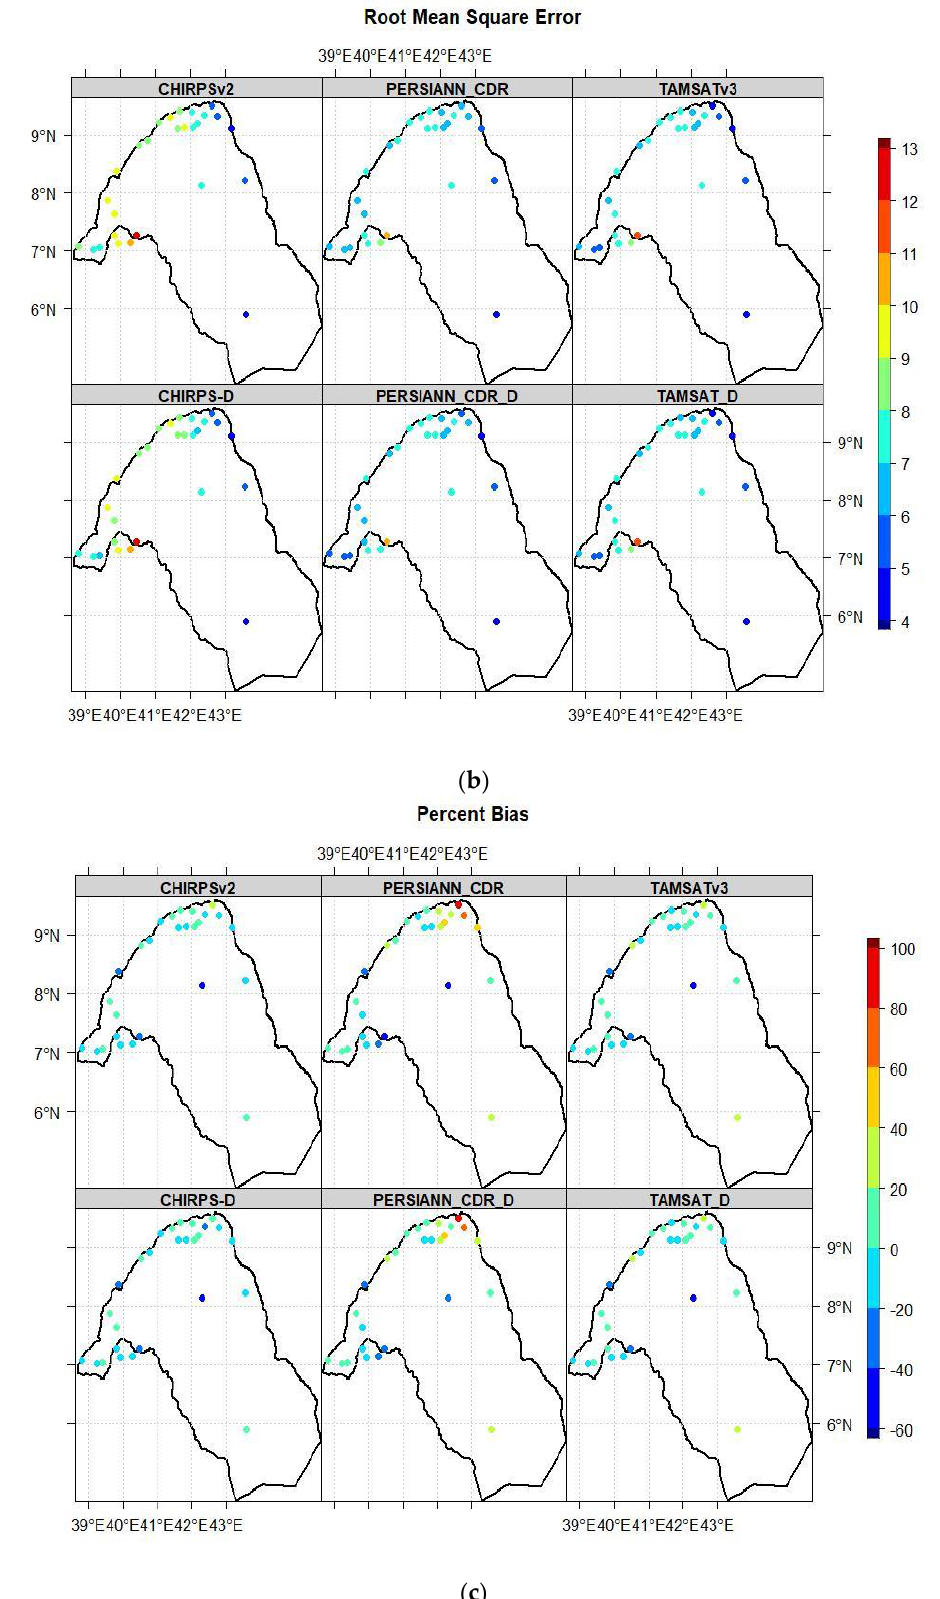
Figure 3. The statistical parameter correlation coefficient ( a ), root-mean-square error ( b ), and percentage bias ( c ) for each station at a daily timescale.